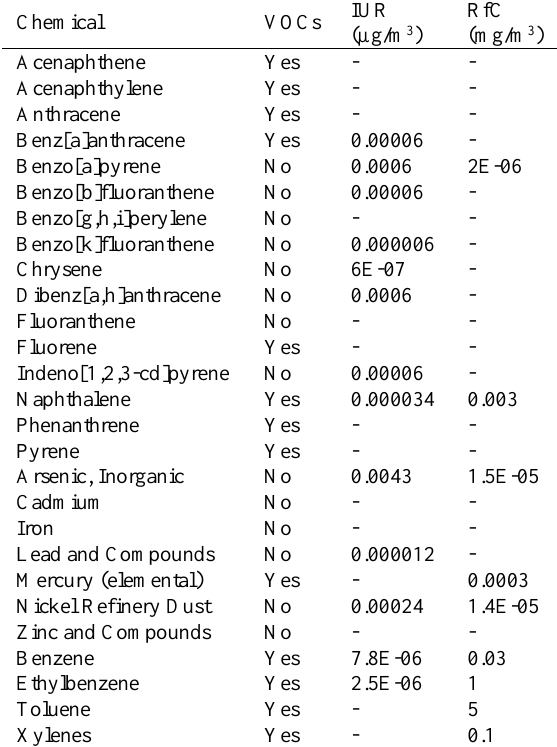
Table 1. Inhalation unit risk factor (IUR) and inhalation reference concentration (RfC) of studied pollutans